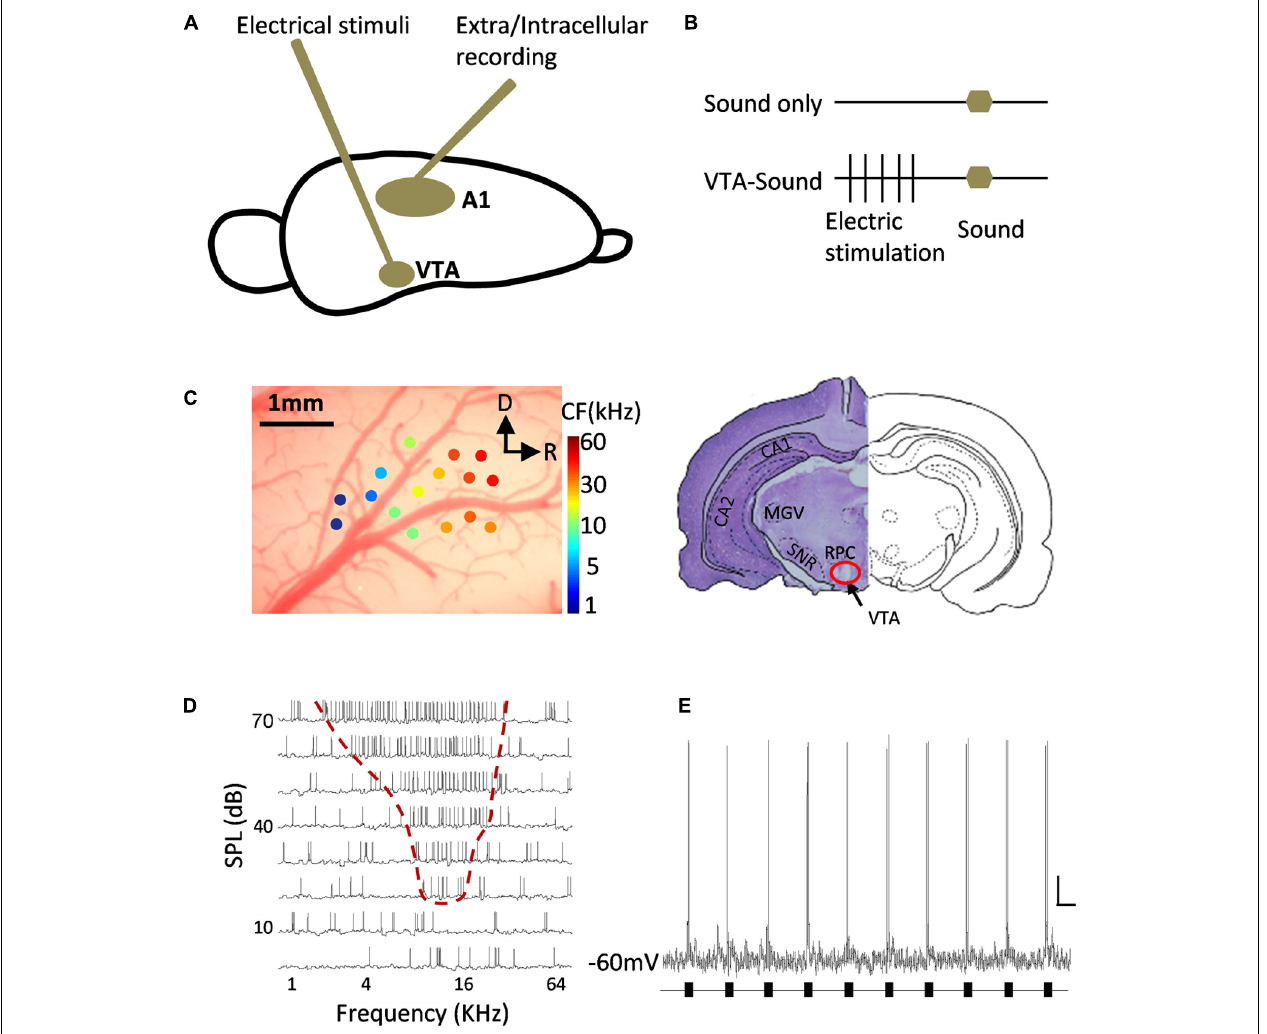
in A1 have typical gradient in CF from rostral to caudal direction. R, rostral; D, dorsal.The lesion at the stimulation site was well matched with the anatomical position ofVTA from the results of cresyl violet staining (right). (D) An example of intracellular recording in A1 neuron showed typical “V” shaped frequency-intensity tonal receptive field. (E) An example of neuronal responses to repeated sound stimulation (black bars) in A1 recorded by in vivo intracellular recording. Scale bar: 10